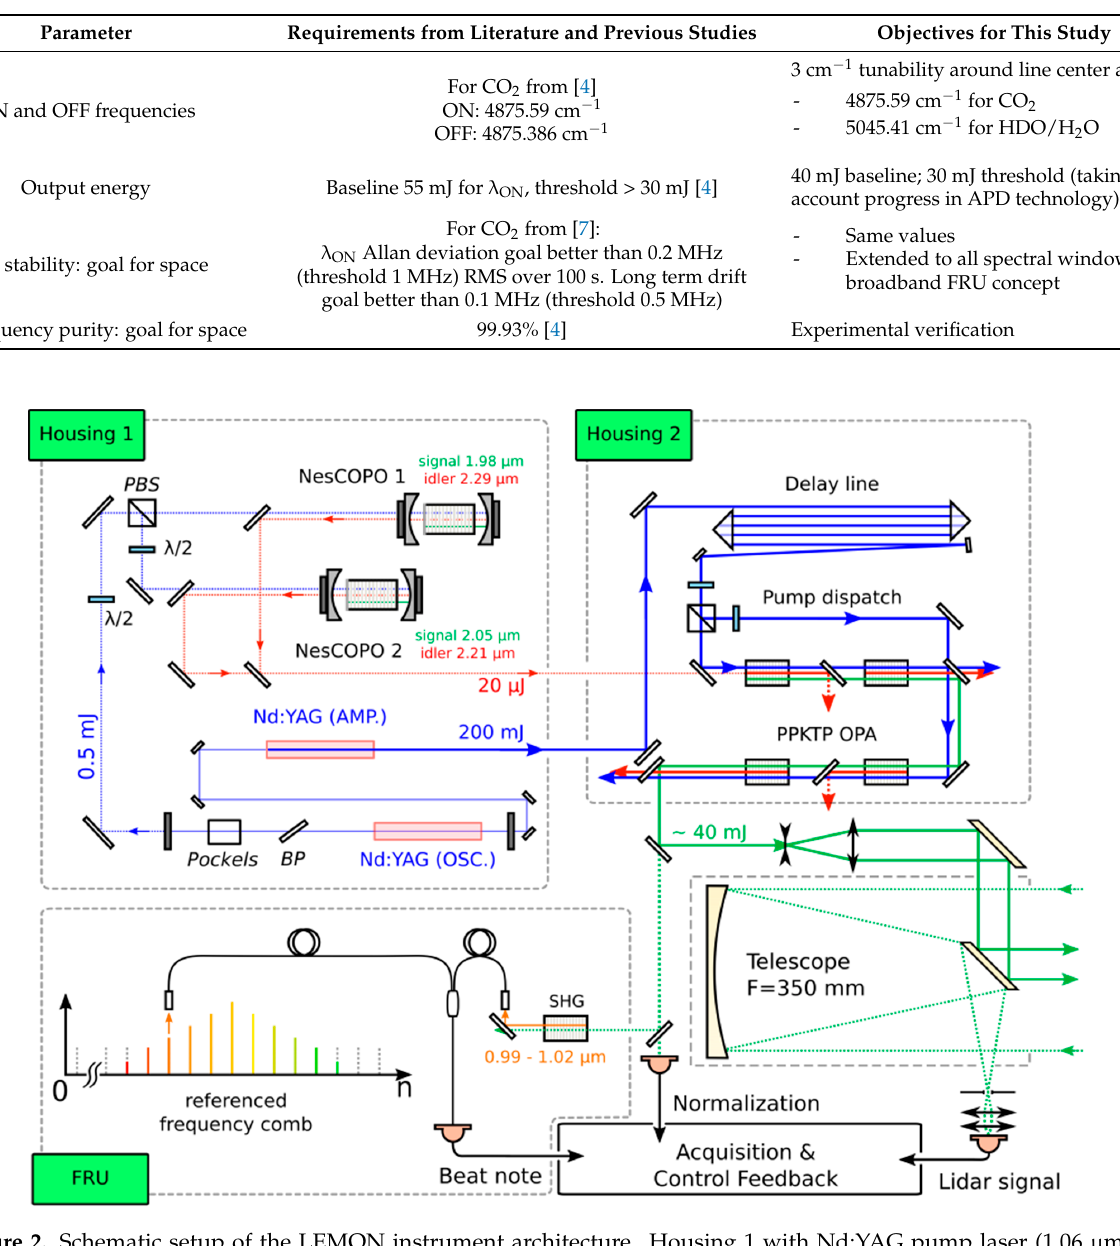
Figure 2. Schematic setup of the LEMON instrument architecture. Housing 1 with Nd:YAG pump laser (1.06 µm) in master-oscillator power amplifier (MOPA) configuration and two nested-cavity optical parametric oscillators (NesCOPO) for wavelength generation around 2.05 µm and 1.98 µm. Housing 2 contains two periodically poled Potassium Titanyle Phosphate crystals (PPKTP) amplification stages and a delay line to compensate for the pulse build-up time in the NesCOPOs. PBS: polarizing beam splitter, OSC: master oscillator, AMP: amplifier, SHG: second harmonic generation, FRU: frequency reference unit. LEMON: Lidar Emitter and Multispecies greenhouse gases Observation.